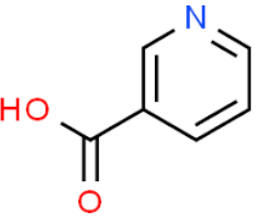
Figure 12. Thiamine structure.